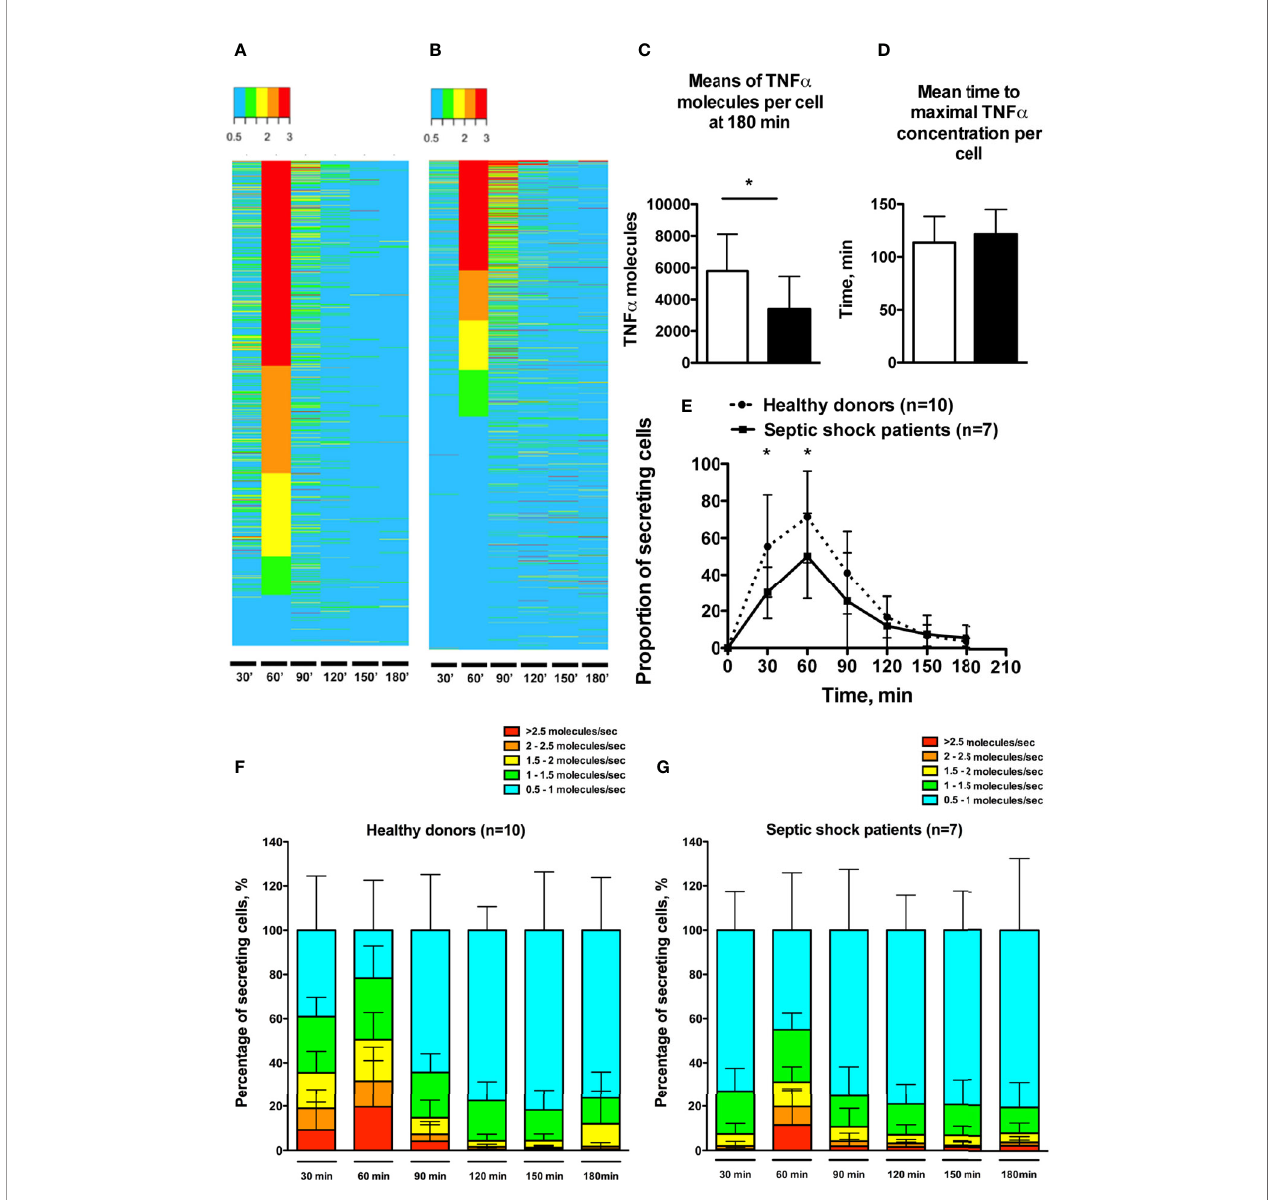
FIGURE 2 | Single-cell dynamic micro fl uidic analysis of monocyte TNF a secretion under LPS stimulation. (A, B) Heatmaps expressing TNF a secretion rate over time in one healthy donor (988 cells) (A) and one septic shock patient (1021 cells) ( B ). Cells were clustered based on TNF a secretion rate at 60 min. Secretion rate is expressed in TNF a molecules per second. (C) Means of maximal amount of TNF a molecules in cells. (D) Mean time to reach the maximal concentration of TNF a in each cell. (E) Proportion of monocytes secreting TNF a (molecules/sec) over time after LPS stimulation. (F, G) Proportions of secreting monocytes clustered by TNF a secretion rates over time in healthy donors (F) and septic shock patients (G) . *p <